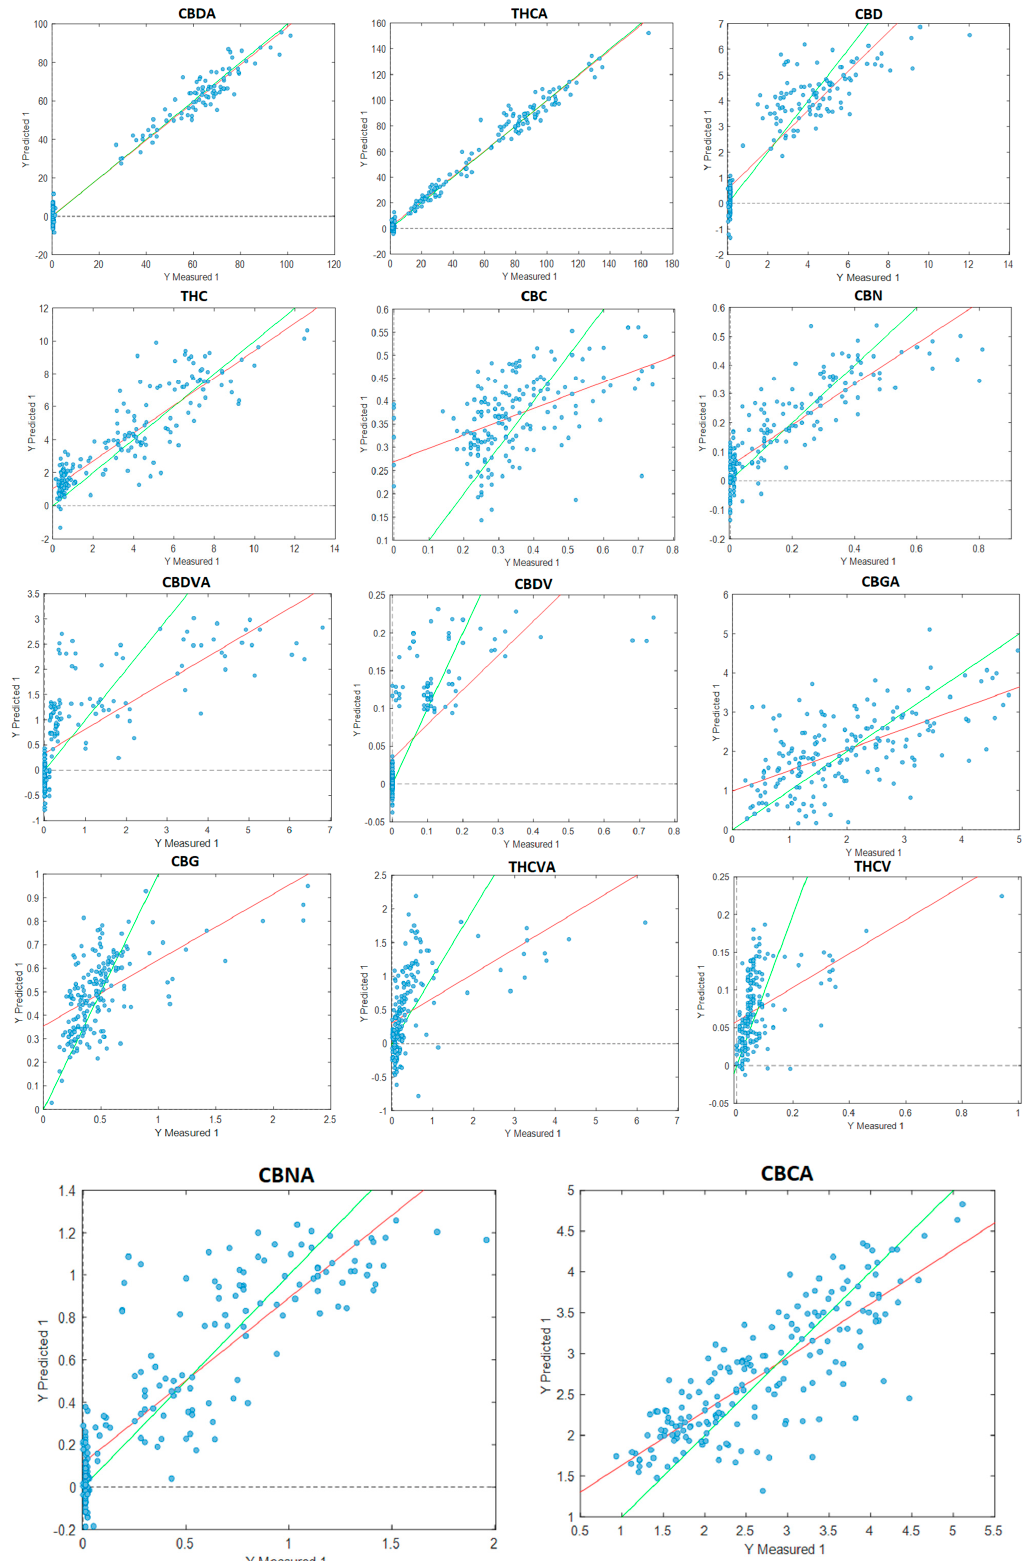
Figure 5. Plot of measured values versus the predicted values of cannabinoids in the validation dataset with data obtained from the VIAVI MicroNIR instrument processed from the PLS_toolbox using the PLS-R tool. Cannabidiolic acid (CBDA), tetrahydrocannabinolic acid (THCA-A), canna- bidiol (CBD), tetrahydrocannabinol (THC), cannabichromene (CBC), cannabinol (CBN), cannabidi- varic acid (CBDVA), cannabidivarin (CBDV), cannabigerolic acid (CBGA), cannabigerol (CBG), tet- rahydrocannabidivarin (THCV), tetrahydrocannabidivarinic acid (THCVA), cannabinolic acid (CBNA) and cannabichromenic acid (CBCA). Units are expressed in mg/g. Green line: line of best fit from reference data; red line: line of best fit from predicted data. Table 4. The different pre-processing methods applied to partial least squares regression models (PLS-R) for the determination of cannabinoid compounds using data from the VIAVI MicroNIR Onsite-W instrument. Region (cm − 1 )